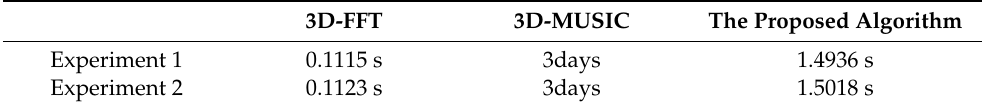
Table 4. The comparison results of computational times for real radar data.